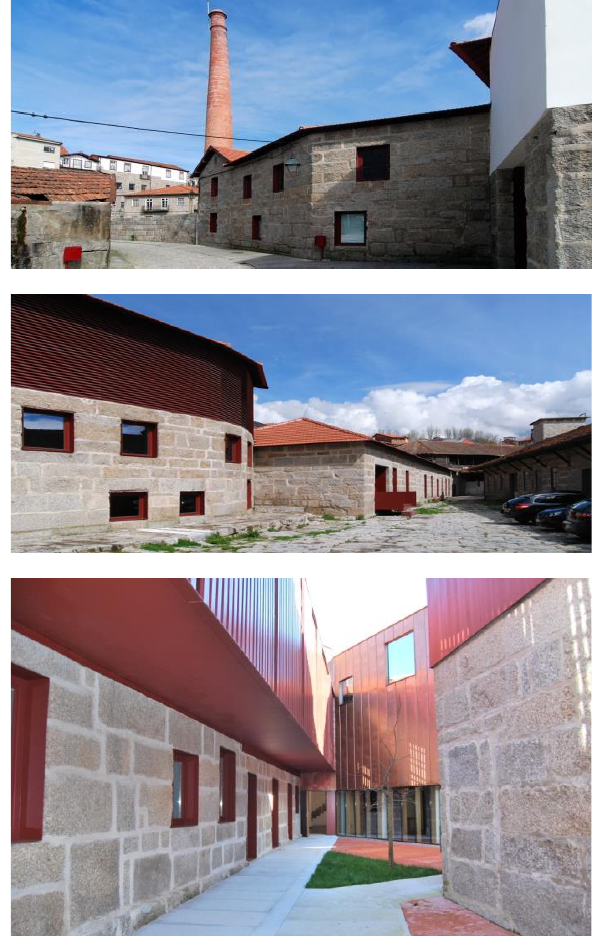
Figure 18, 19, and 20. Centre for Advanced Post-graduate Formation, Universidad do Minho Source: